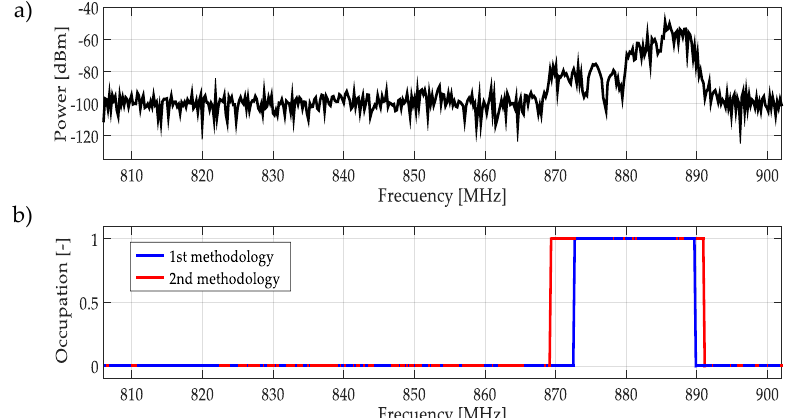
Figure 22. ( a ) A real signal obtained from the frequency band [806–902] MHz. ( b ) The result of applying both methodologies to the real signal in terms of spectrum occupancy. In this case, the second methodology gives a better frequency edge detection.